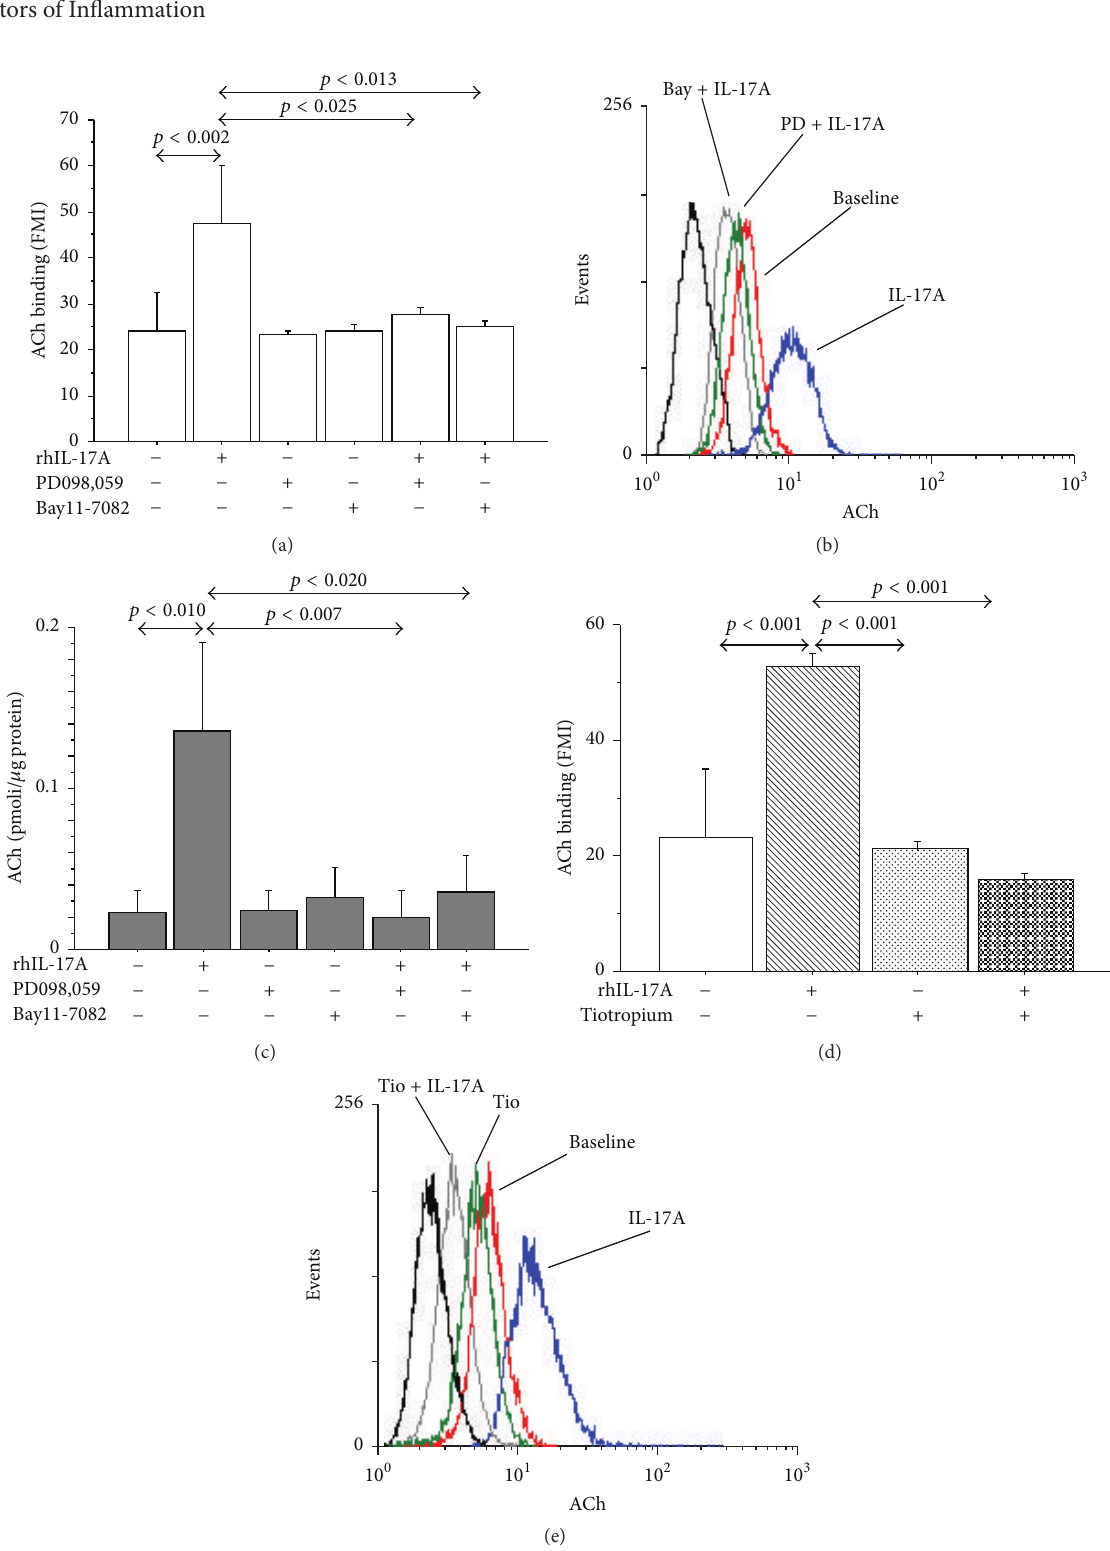
Figure 5: Effects of PD098,059 (25 𝜇 M), Bay11-7082 (50 𝜇 M), and Tiotropium (100nM) on ACh in 16-HBE cells. Cells were preincubated for 1h with PD098,059 (25 𝜇 M) or Bay11-7082 (50 𝜇 M) and then stimulated with rhIL-17A 20 ng/mL for 24h to evaluate (a) ACh binding by flow cytometry. Bars represent mean ± SD of fluorescence mean intensity (FMI). (b) Representative flow cytometry is shown. (c) ACh production, expressed as pmoli/ 𝜇 g protein. Bars represent mean ± SD of three different experiments. Then, 16-HBE cells were preincubated for 1h with Tiotropium (100nM) and then stimulated with rhIL-17A 20ng/mL for 24 h to evaluate (d) ACh binding by flow cytometry. Bars represent mean ± SD of fluorescence mean intensity (FMI). (e) Representative flow cytometry is shown. Statistical analysis was performed by ANOVA test followed by Fisher’s PLSD multiple comparison test. The black curve represents the anti-IgG isotype negative control